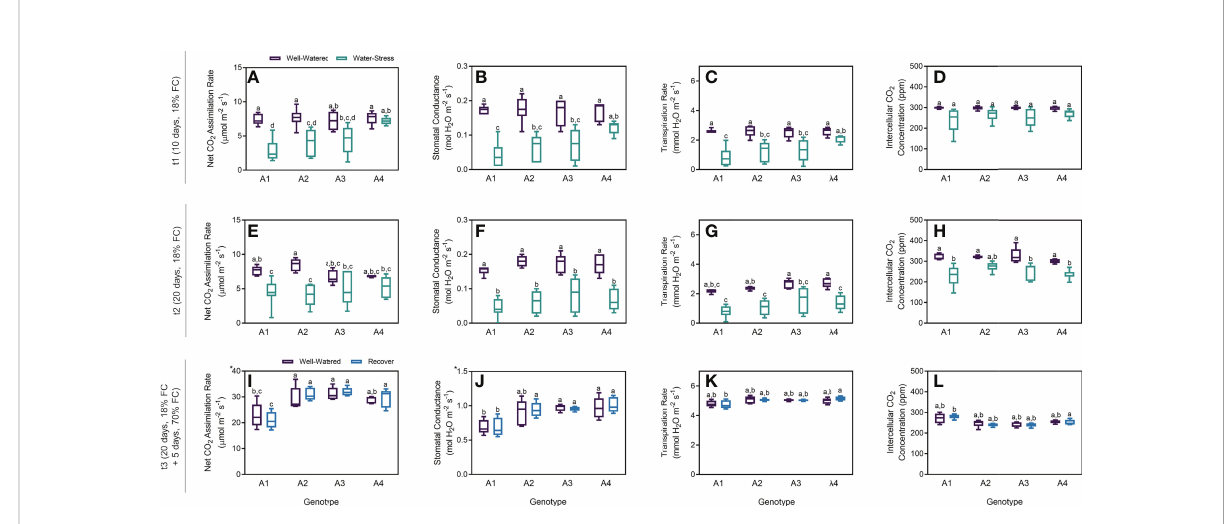
FIGURE 1 Physiological parameters measured on t1 (10 days), t2 (20 days) and t3 (20 + 5 days) on 4 genotypes (A1, A2, A3 and A4) and 3 water regimes (well-watered, water-stress and recover): net CO 2 assimilation rate at t1 (A) , stomatal conductance at t1 (B) , transpiration rate at t1 (C) , intercellular CO 2 concentration at t1 (D) , net CO 2 assimilation rate at t2 (E) , stomatal conductance at t2 (F) , transpiration rate at t2 (G) , intercellular CO 2 concentration at t2 (H) , net CO 2 assimilation rate at t3 (I) , stomatal conductance at t3 (J) , transpiration rate at t3 (K) , and intercellular CO 2 concentration at t3 (L) . Means ± SDs, n = 5-7, different letters indicate signi fi cant differences between treatments at P ≤ 0.05 according to a Tukey ’ s multi comparison